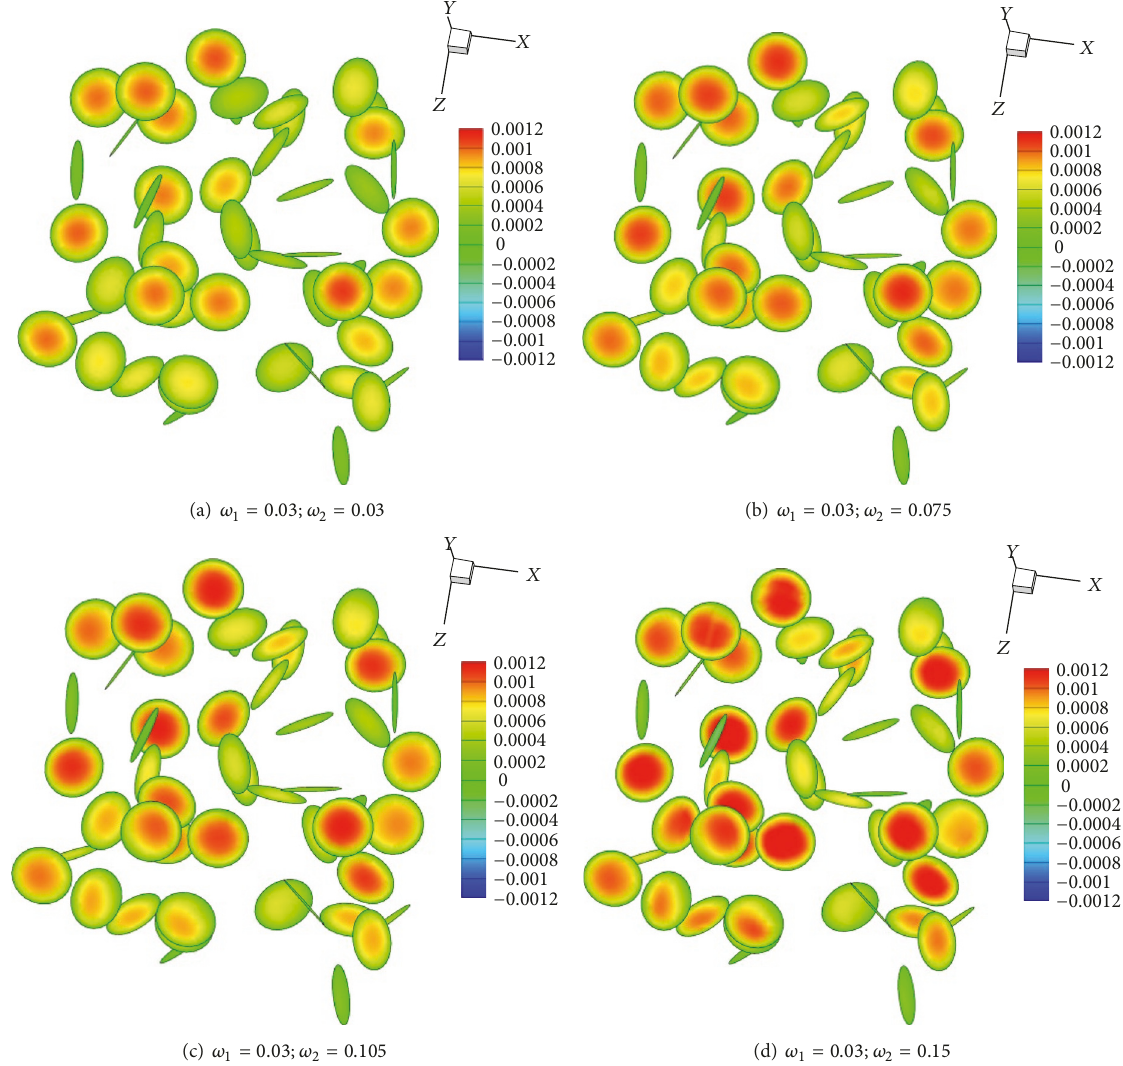
Figure 14: The microcracks’ opening